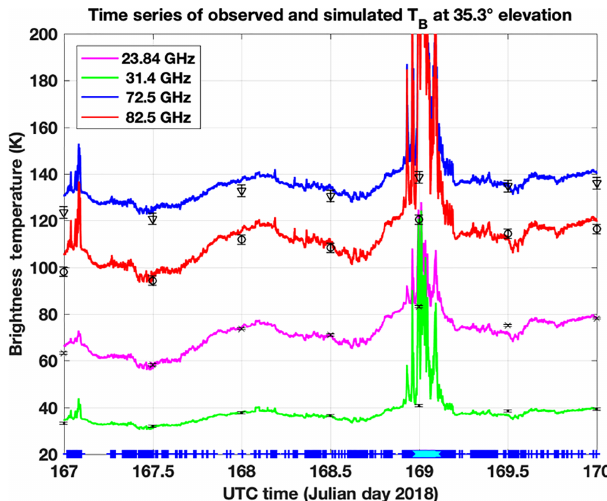
Figure 2. Zenith downwelling T B uncertainty ( σ (T B )) due to the uncertainty in O 2 and H 2 O absorption model parameters. Six clima- tological atmospheric conditions (color-coded) have been used to compute Cov (p) (see Sect. 2.2). σ ( T B ) is computed as the square root of the diagonal terms of Cov ( T B ) . This figure is similar to Fig. 6 in Cimini et al. (2018), although σ ( T B ) was recomputed to cover a wider frequency range.